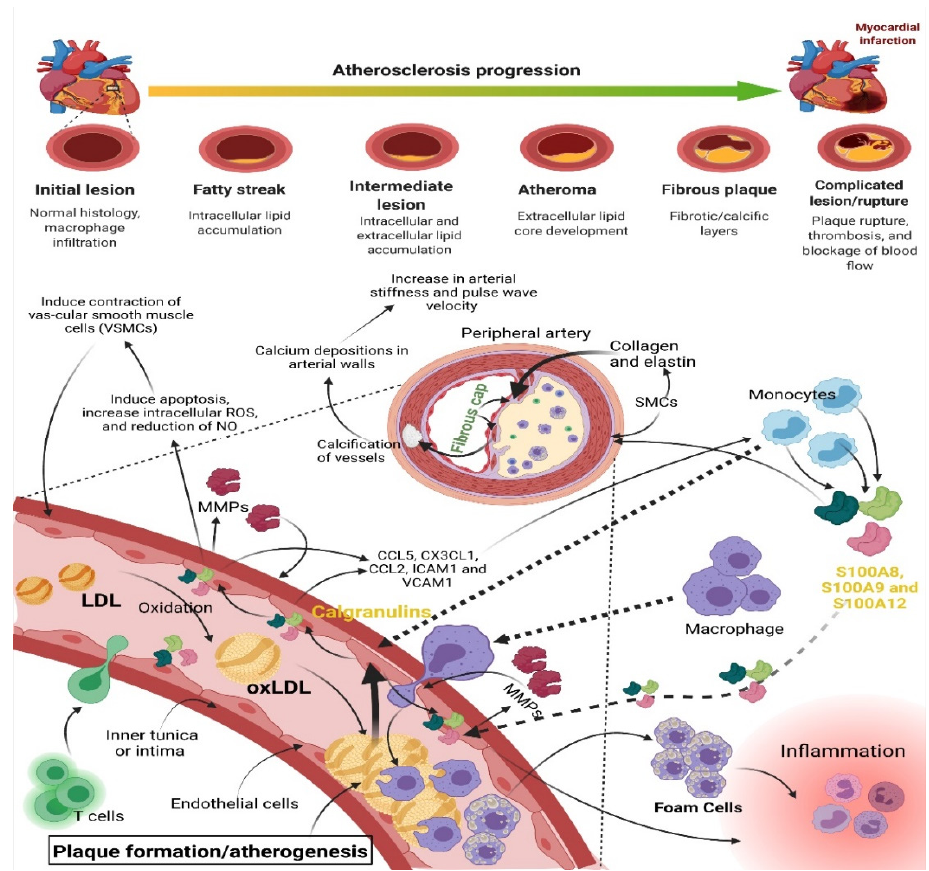
Figure 7. An illustration of the progression of atherosclerosis, a chronic inflammatory disease. The accumulation of oxidized LDL (oxLDL) triggers the recruitment of macrophages, which consume oxLDL and transform into foam cells. This mechanism causes endothelial and SMC dysregulation and malfunction, leading to pro-inflammatory cytokines, such as CCL5, CX3CL1, CCL2, ICAM1, and VCAM1, into the bloodstream. In addition, this results in the recruitment of even more immune cells, including monocyte and T-cells. Activated monocytes secrete calgranulins, which activate TLR-4 and RAGE receptors. In addition, the S100A8/A9 heterodimer and A12 activate SMC and endothelial cells, and activated endothelial cells induce apoptosis. In addition, this initiates and increases intracellular ROS while causing a decrease in NO and the release of MMPs, which ultimately causes contraction of VSMCs and inflammation. SMC, on the other hand, secretes collagen and elastin, which form a fibrous cap. NO, nitrous oxide; SMC, smooth muscle cell; RAGE, Receptor For Advanced Glycation End-Products; TLR-4, Toll-Like Receptor-4; ROS, reactive oxygen species; VSMCs, vascular smooth muscle cells; MMPs, matrix metalloproteinases. CCL5, CX3CL1, CCL2; chemotactic cytokine or chemokine. ICAM1, Intercellular Adhesion Molecule 1. Created with